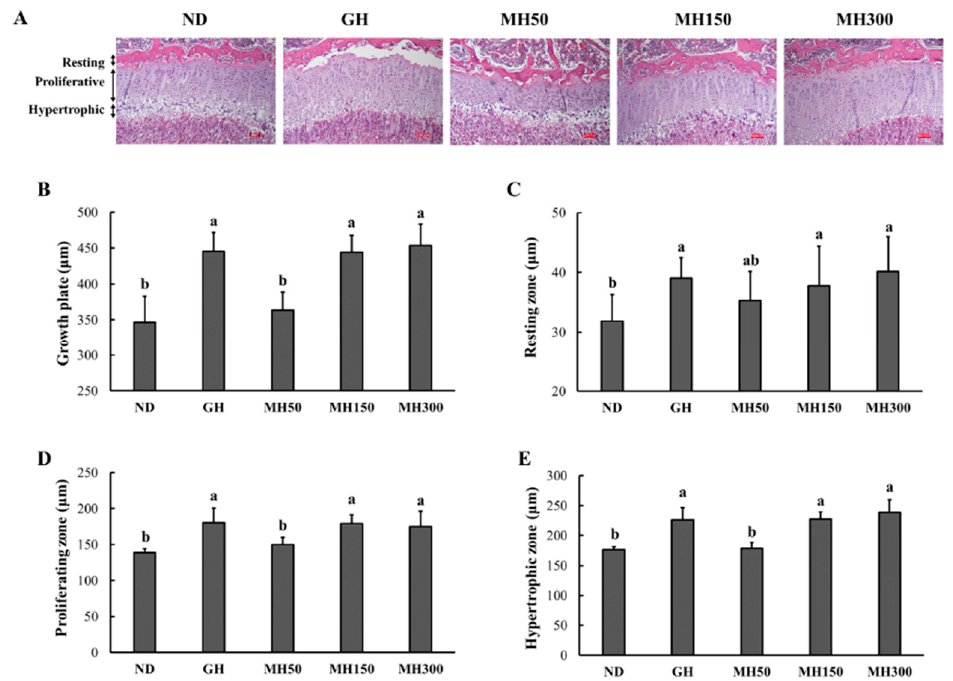
Figure 4. The effect of dietary administration of a mixture of H. japonicus (MH) on growth plate in SD rats. Representative example of the proximal end of the tibia stained with H&E ( A ), growth plate ( B ) resting zone ( C ), proliferating zone ( D ), and hypertrophic zones ( E ). ND (normal diet control): AIN93M diet; GH: AIN93M diet + intraperitoneal injection of 0.37 mg/kg b.w./day recombinant growth hormone; MH50: AIN 93G diet supplemented with MH 50 mg/kg b.w.; MH150: AIN 93G diet supplemented with MH 150 mg/kg b.w.; MH300: AIN 93G diet supplemented with MH 300 mg/kg b.w. Values are presented as means ± SD. Different letters indicate a significant difference with 𝑝 < 0.05, as determined by Duncan’s multiple range test.